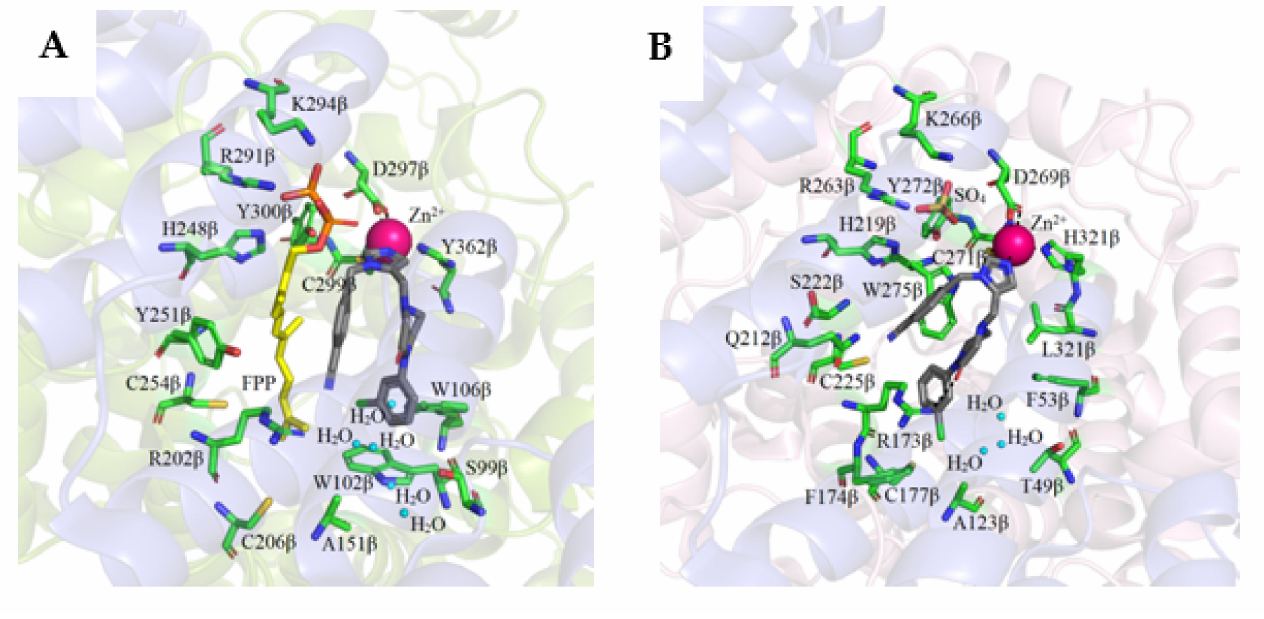
Figure 10. Structure of farnesyltransferase complexed with L-778,123 ( A ) (PDB: 1S63) and geranylger- anyltransferase type-I complexed with L-778,123 ( B ) (PDB: 1S64). (Created in the PyMOL Molecular Graphics System, Version 2.5.2 Schrödinger,